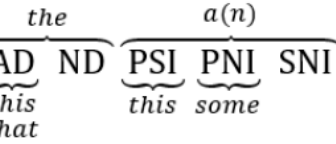
Figure 2. Forms represented along the Reference Hierarchy for American English.